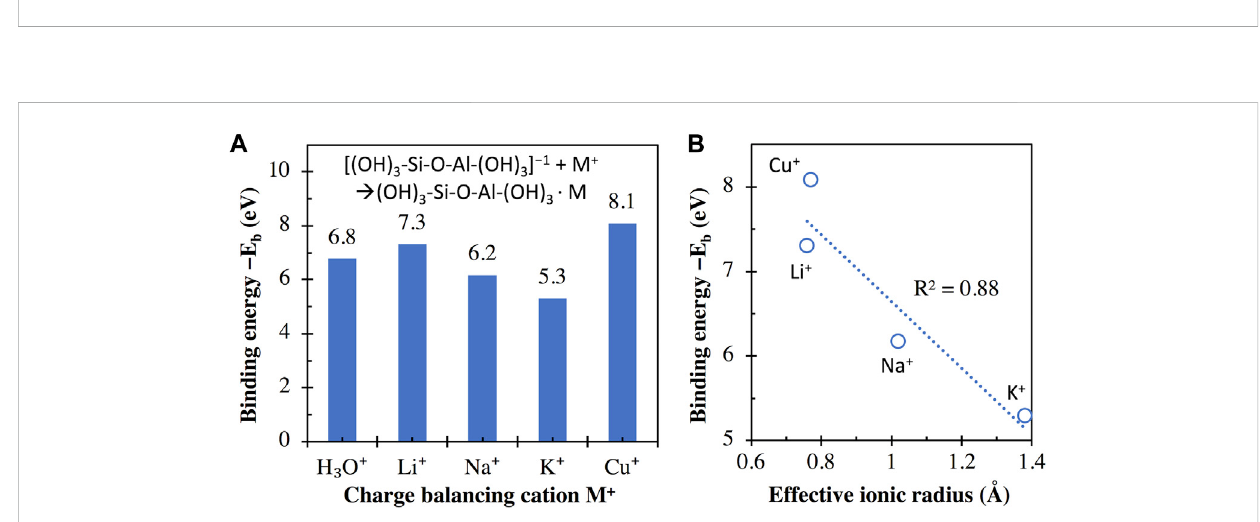
FIGURE 4 (A) Binding energies (in eV) between the aluminosilicate dimer (i.e., [(OH) 3 -Si-O-Al-(OH) 3 ] − 1 ) and different monovalent cations, calculated using Eq. 1, with the total energies of individual components in Eq. 1 given in Supplementary Table S1 of Supporting Information. (B) Comparison of binding energiesin (A) andtheeffectiveionicradius(forVI-coordinatedM + )ofthemonovalentmetalcations.The R 2 valueforlinearregressionisalsogivenin (B)